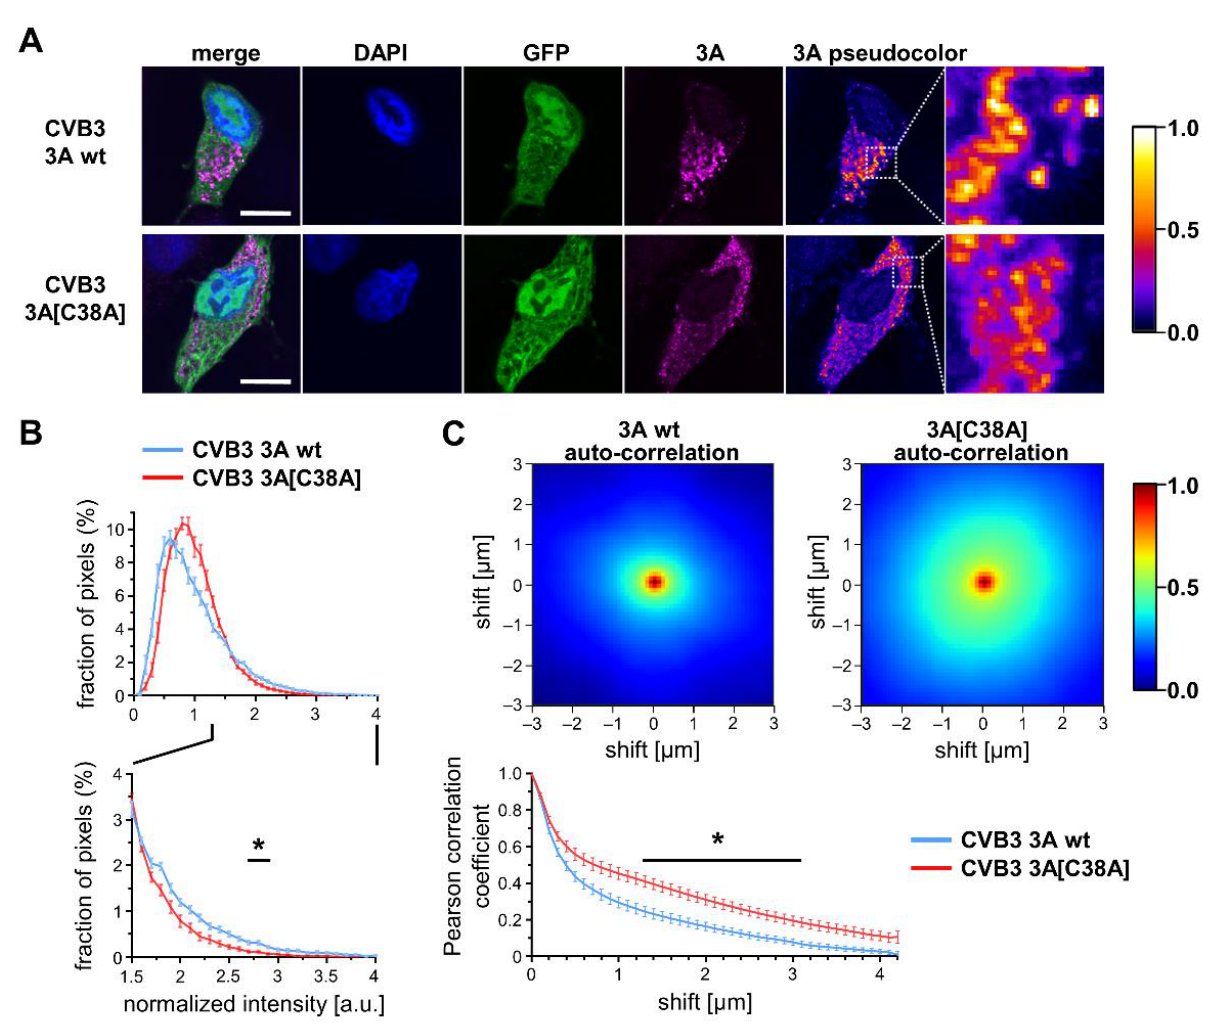
Figure 2. Cysteine 38 of protein 3A affects the subcellular distribution of the viral 3A protein. ( A ) Confocal microscopy of HeLa cells infected with GFP-CVB3 variants at MOI 1 for 5 h. GFP signal reflecting CVB3 replication, staining of DNA (DAPI, blue), and protein 3A (magenta). Scale bar: 10 µm. ( B ) Quantitative comparison of anti-3A immunofluores- cence intensity distributions ( n = 15) depicted in ( A ). ( C ) Autocorrelation-based image correlation spectroscopy of anti- 3A immunofluorescence shown in ( A ). Two-dimensional plots depicting t h e auto-correlation of x/y- shifted confocal images to assess cluster sizes, which are collapsed into a 1D Pearson correlation coefficient plot ( n = 15). In order to quantitatively compare the immunofluorescence frequency distributions and auto-correlation curve of the two strains, differences between single bins from GFP-CVB3 3Awt and GFP-CVB3 3A[C38A] were tested with a one- sample t -test against zero, * p < 0.05. We used a significance level of 0.05 and Bonferroni correction to correct for the multiple testing of several bins.